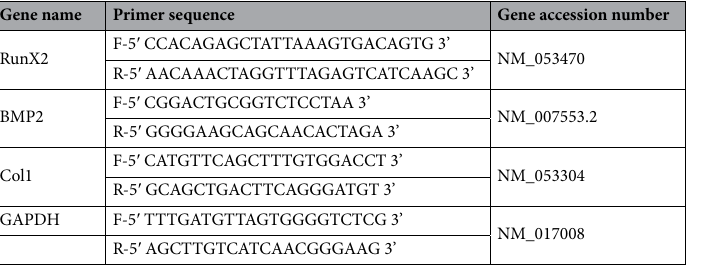
Table 1. Primer sequences of various genes used for